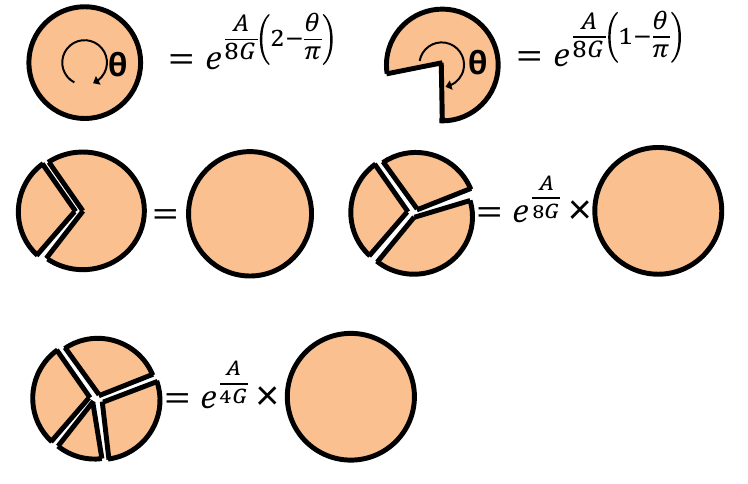
Figure 4 . Pasting rules of gravity